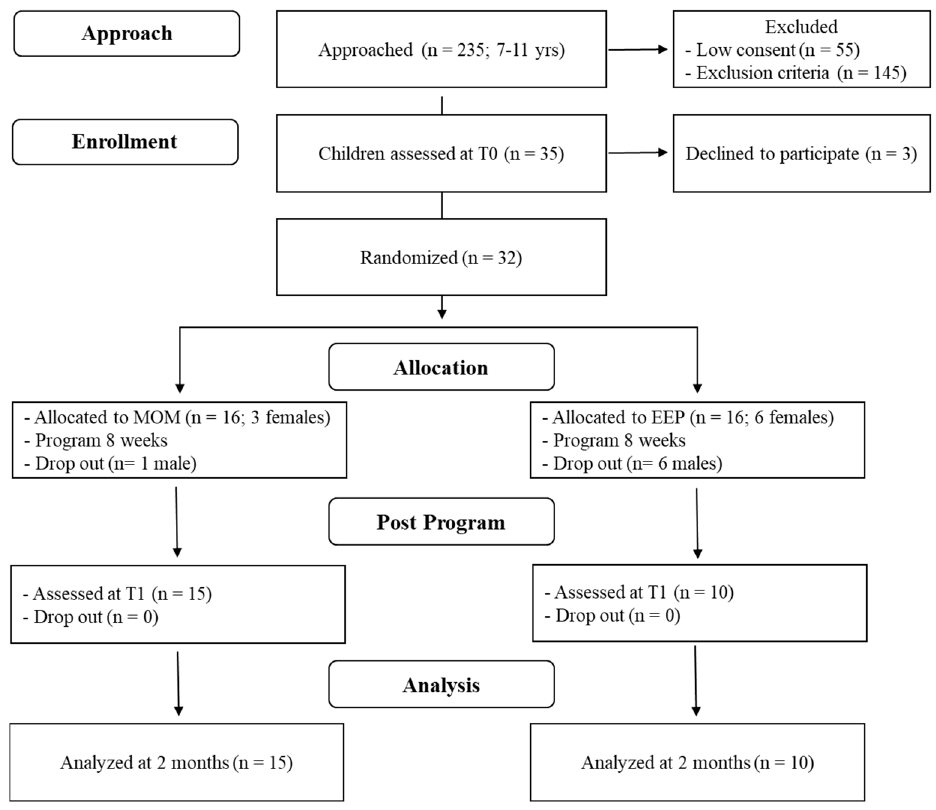
Figure 1. Study flow diagram.